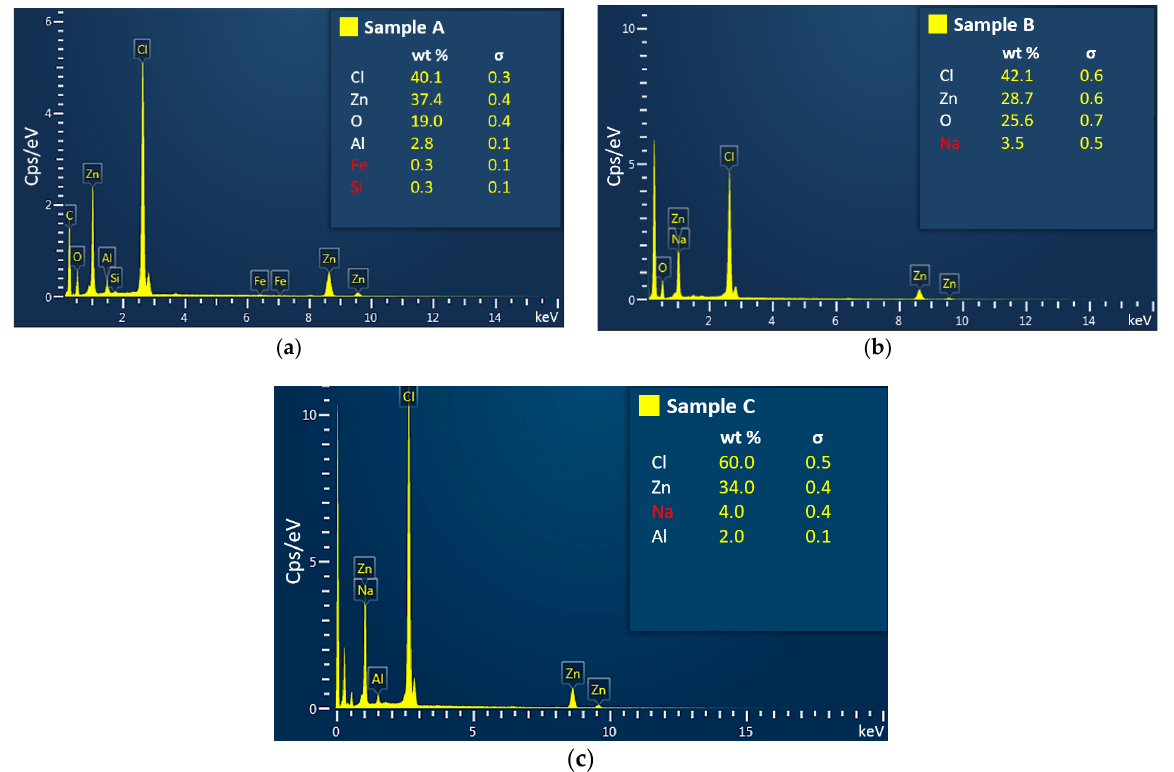
Figure 2. Particle morphology of zinc flue samples A, B, and C.